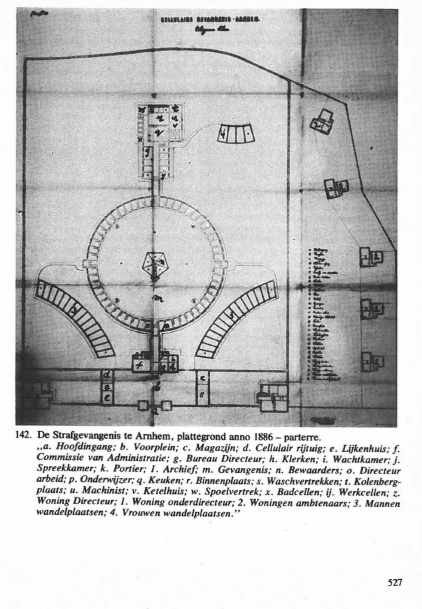
Figure 1. The Koepelgevangenis or dome prison of Arnhem, Netherlands, by J.F. Metzelaar,